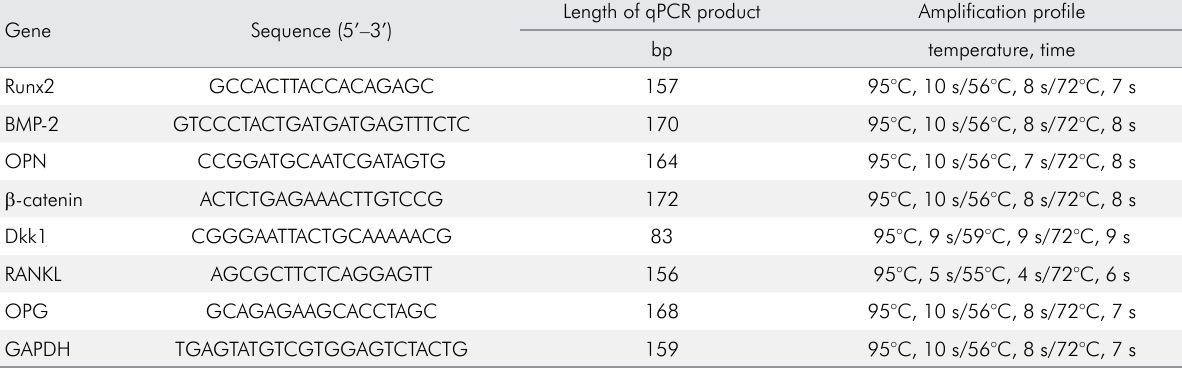
Table. Primer sequences, amplification profiles, and the estimated length of the qPCR product for each gene. Gene Sequence